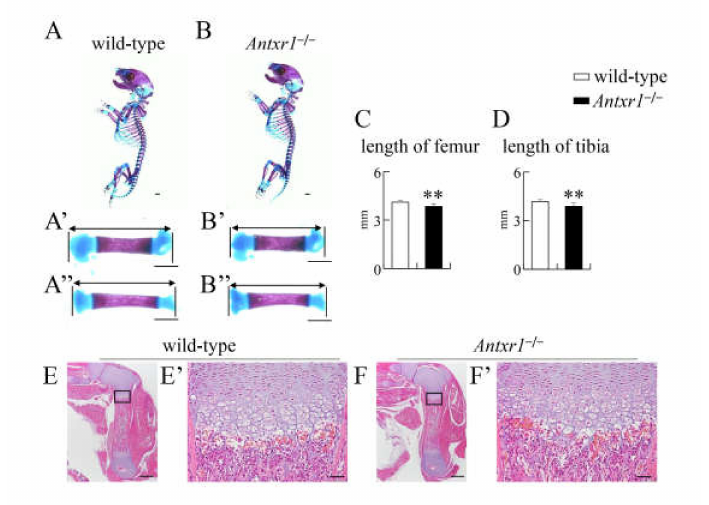
Figure 4. Skeletal system and histological analysis of wild-type and Antxr1 – / – newborns: ( A , B ) Lateral view of the whole skeletons ( A , B ) and magnified pictures of femurs ( A’ , B’ ) and tibiae ( A” , B” ) in wild-type ( A ) and Antxr1 – / – ( B ) newborns. ( C , D ) The lengths of femurs ( C ) and tibiae ( D ): The lengths of both sides of femurs and tibiae were measured using skeletal preparations of 4 wild-type and 3 Antxr1 – / – newborns, as shown in A’ , B’ , A” and B” . Versus wild-type newborns, ** p < 0.01. ( E , F ) H-E staining using femoral sections from wild-type ( E ) and Antxr1 – / – ( F ) newborns. The boxed regions in E and F are magnified in E’ and F’, respectively. Scale bars: 1 mm ( A , B ), 500 µ m ( E , F ), and 100 µ m ( E’ , F’ ). The number of mice analyzed: H-E staining, wild-type: 2, Antxr1 – / – :